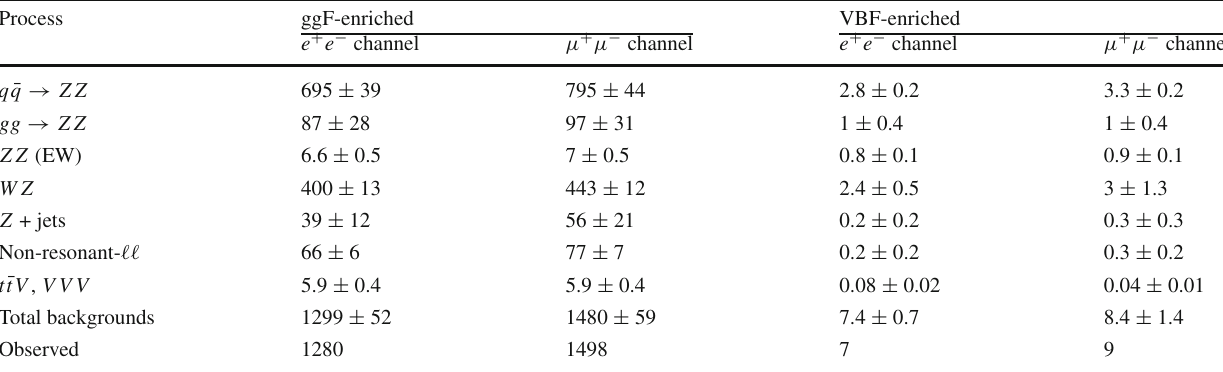
Table 4 Expected and observed numbers of events together with their uncertainties in the (cid:3) + (cid:3) − ν ¯ ν final state, for the ggF- and VBF-enriched categories. The expected numbers of events, as well as their uncertain-